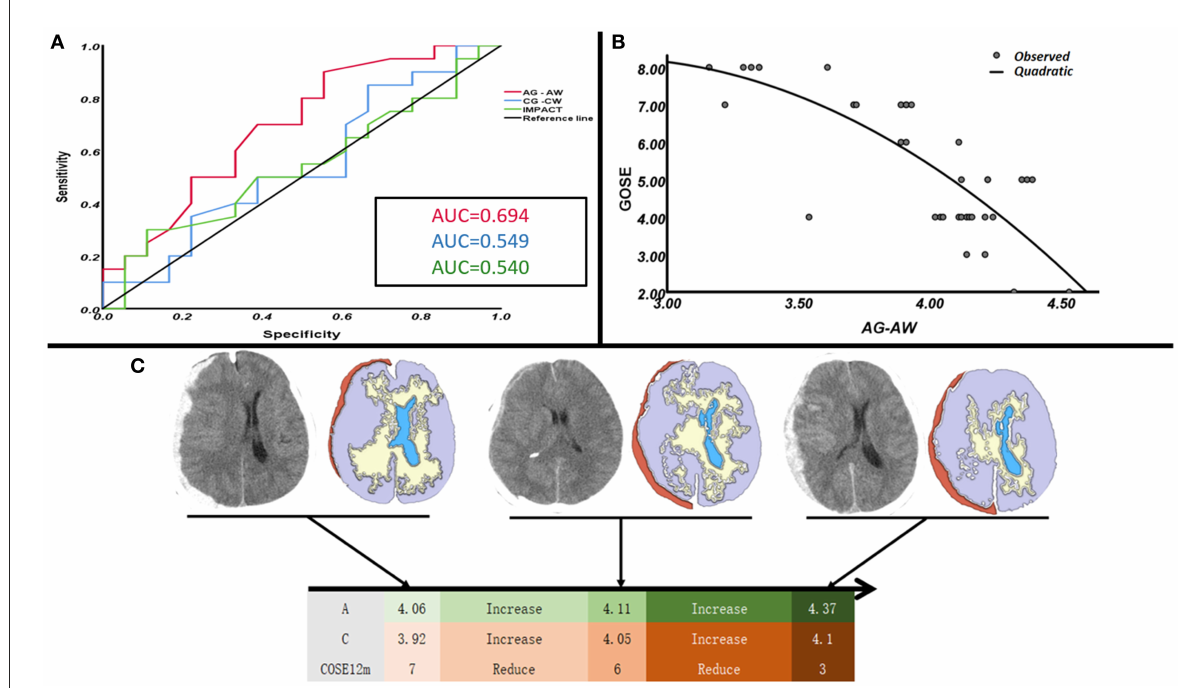
FIGURE3 Evaluation of the prognosis of patients with ASDH using the difference between the gray matter density and the IMPACT database (surgical group n = 38). (A) To evaluate the prognosis of patients with ASDH using the gray and white matter’s density difference value and the accuracy of the IMPACT database. (B) With the increase of the gray and white matter’s density difference value, the GOSE score of patients with ASDH decreased. (C) In the CT visual quantitative analysis, the loss of gray and white matter density differentiation indicates a poor prognosis in ASDH patients. Note that A in (C) , the compressed side of the hematoma; note that C in (C) , the contralateral side of the hematoma. (The prognosis is assessed using the GOSE 12-month